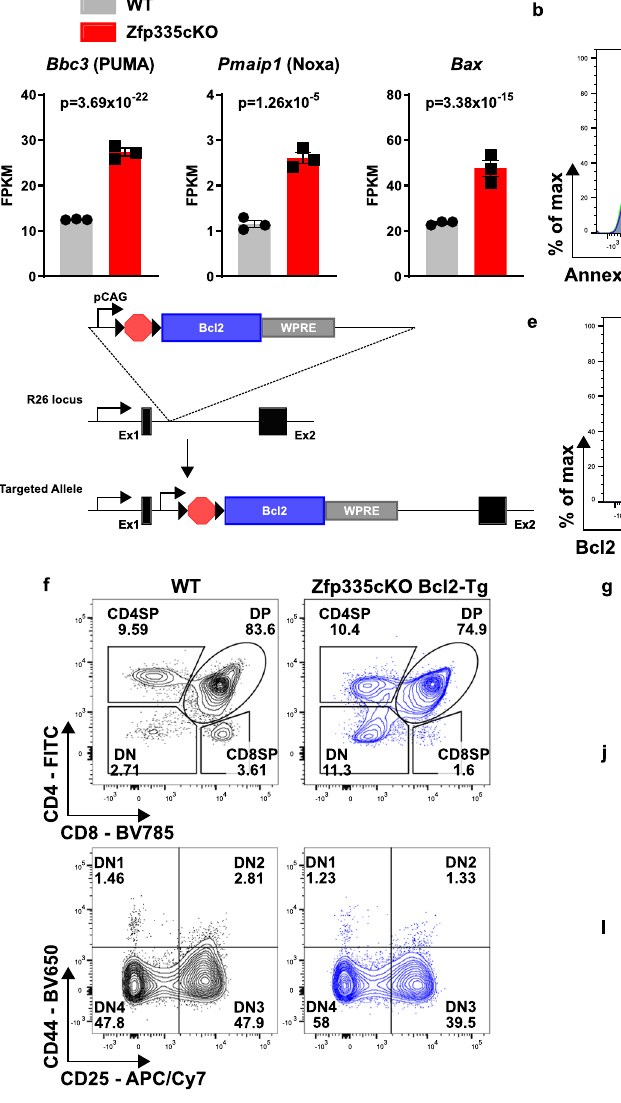
Fig. 3 | Bcl2 overexpression rescues Zfp335-de fi cient thymocytes from apop- tosis. a Expression of proapoptotic Bcl2-family genes Bbc3 , Pmaip1 , or Bax from RNA-seq of control ( n =3) or Zfp335cKO ( n =3) DP thymocytes. Representative gating ( b ) and quanti fi cation ( c ) of apoptosis among Zfp335cKO thymocytes transduced with Bcl2 or GFP RV after 5 days of OP9-DL1 culture ( n =5 male and female mice). d Schematic diagram of Rosa26 LSL-Bcl2 transgene generation. e Representativeexpressionofisotypecontrol(openblack)orBcl2inWT(gray)or Zfp335 fl / fl R26 LSL-Bcl2 E8 III -cre (blue) DN3, DN4, or DP thymocytes. f Gating for identi- fi cationofthymocytesubsetsinWT(gray)or Zfp335 fl / fl R26 LSL-Bcl2 E8 III -cre